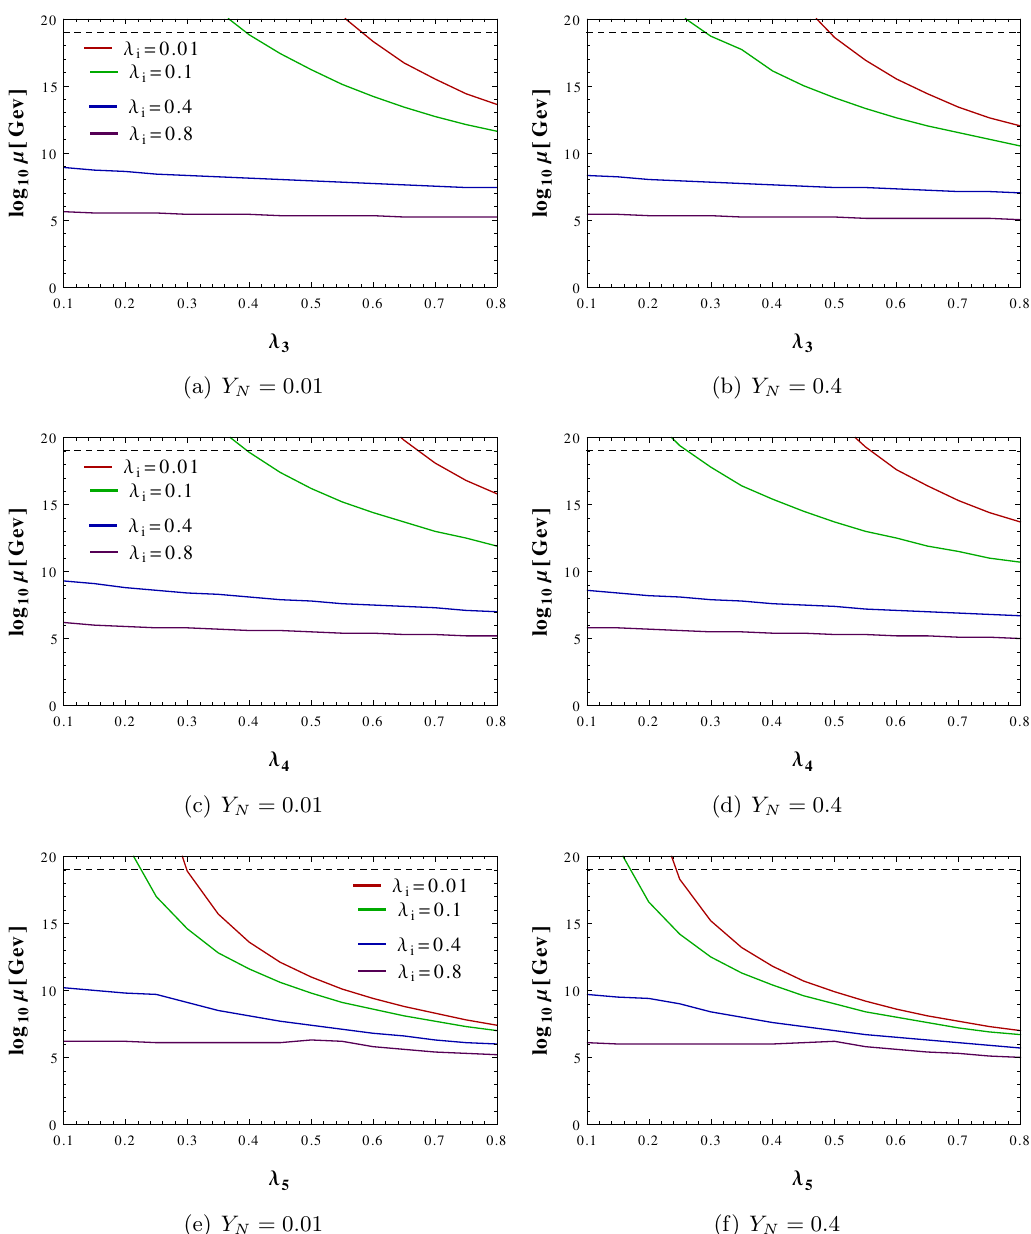
Figure 3 . Perturbative limits of (cid:21) 3 ; (cid:21) 4 and (cid:21) 5 for various (cid:21) i s and Y N = 0 : 01 ; 0 : 40 at EW scale. The colour codes are presented as: very weak ( (cid:21) i = 0 : 01 in red), weak ( (cid:21) i = 0 : 10 in green), moderate ( (cid:21) i = 0 : 40 in blue) and strong ( (cid:21) i = 0 : 80 in purple) couplings respectively with two generations of fermionic triplet in the SM plus ID plus Type-III ISS